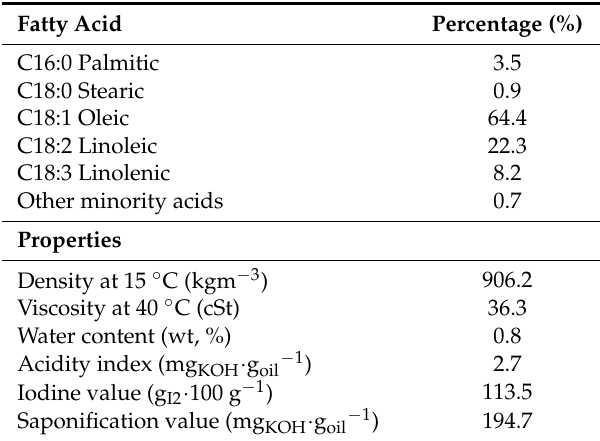
Table 1. Rapeseed oil fatty acid profile and